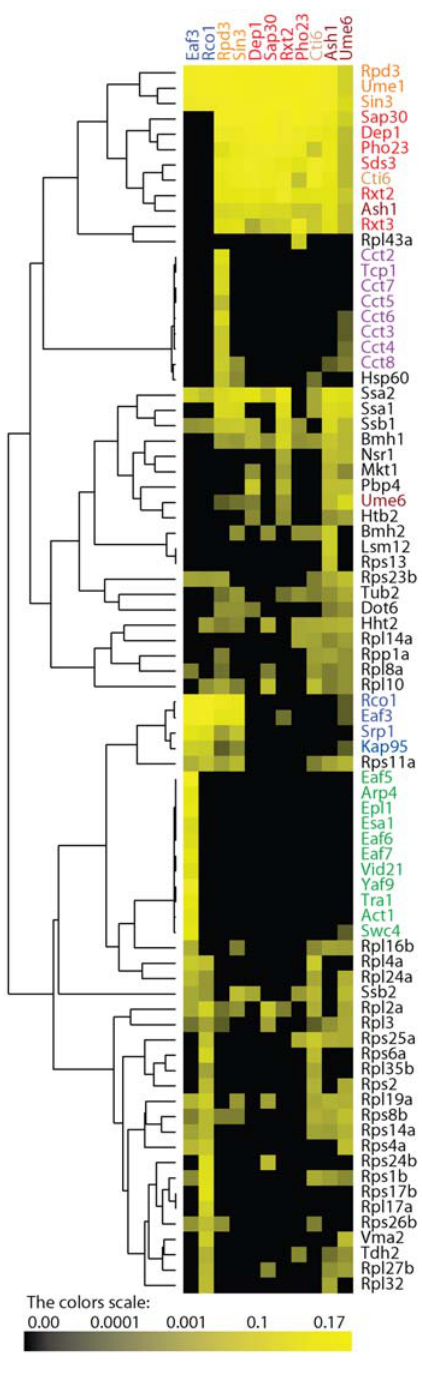
Figure 1. Hierarchical clustering on the wild-type purifications. A hierarchical cluster was performed on the relative protein abundances expressed as dNSAFs. Each column represents an isolated purification, and each row represents an individual protein (prey). The color intensity represents protein abundance with the brightest yellow indicating highest abundance and decreasing intensity indicating decreasing abundance. Black indicates that the protein was not detected in a particular purification. The components of the RPD3L are colored in red, the components of the RPD3S complex are colored in blue, Ash1 and Ume6 are colored in dark red, and Cti6 is colored in light brown. The shared module is colored in orange.